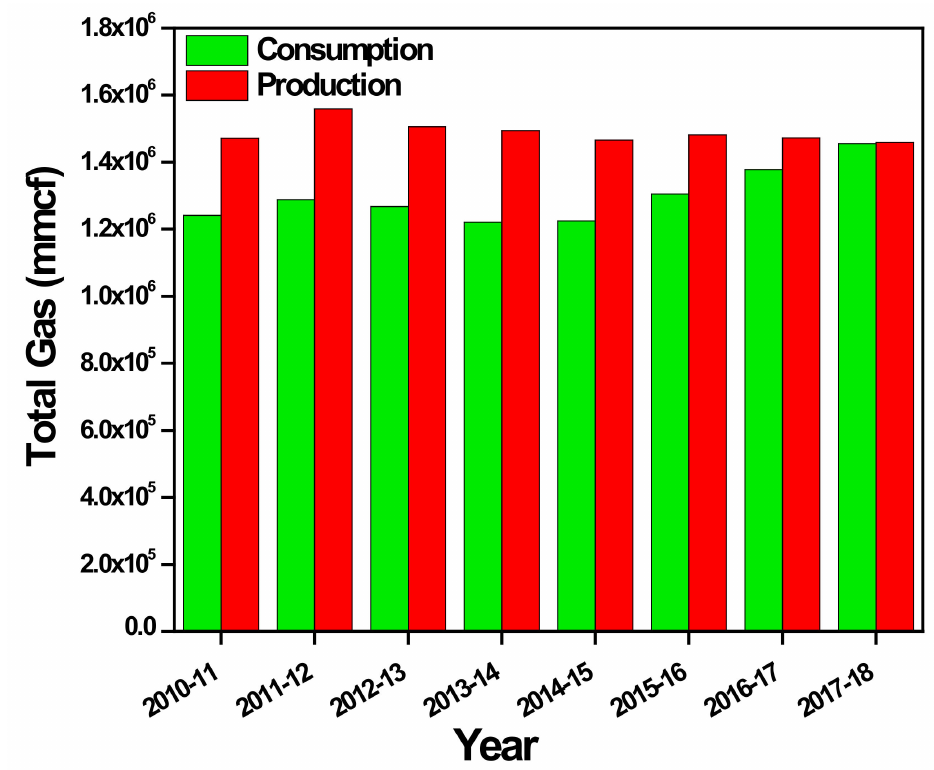
Figure 5. Total production and consumption of gas in Pakistan [5].